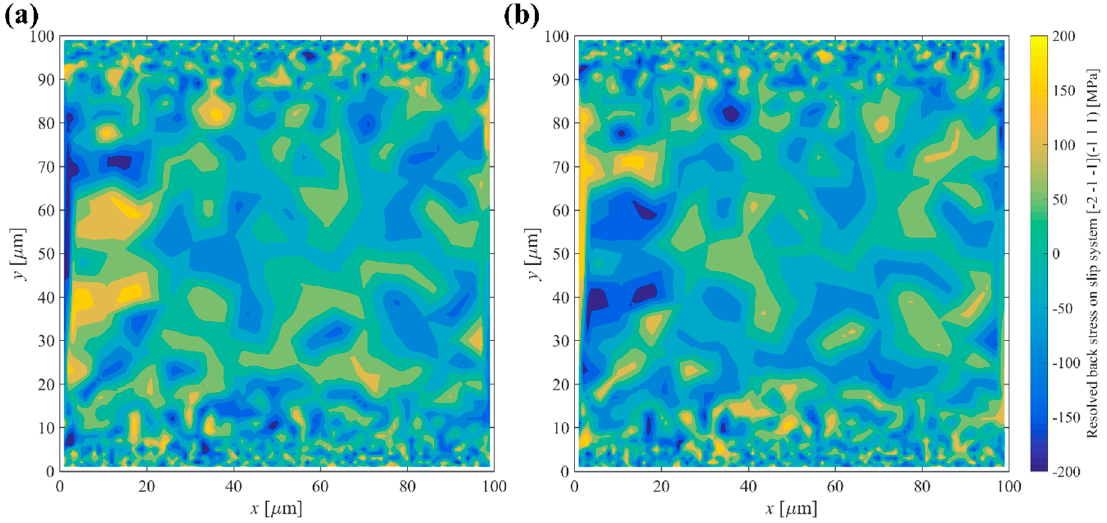
Figure 10. Resolved back-stress on slip 16 for specimens with gradient structures under ( a ) tension and ( b ) compression. Results are shown at 2.5% strain.